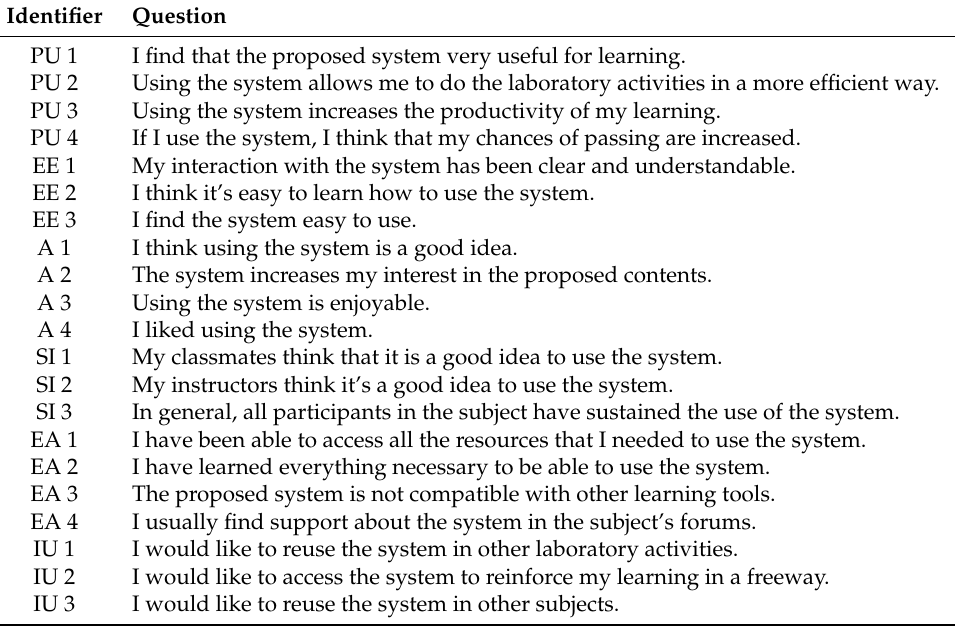
Table A1. Survey Employed for building the UTAUT/TAM